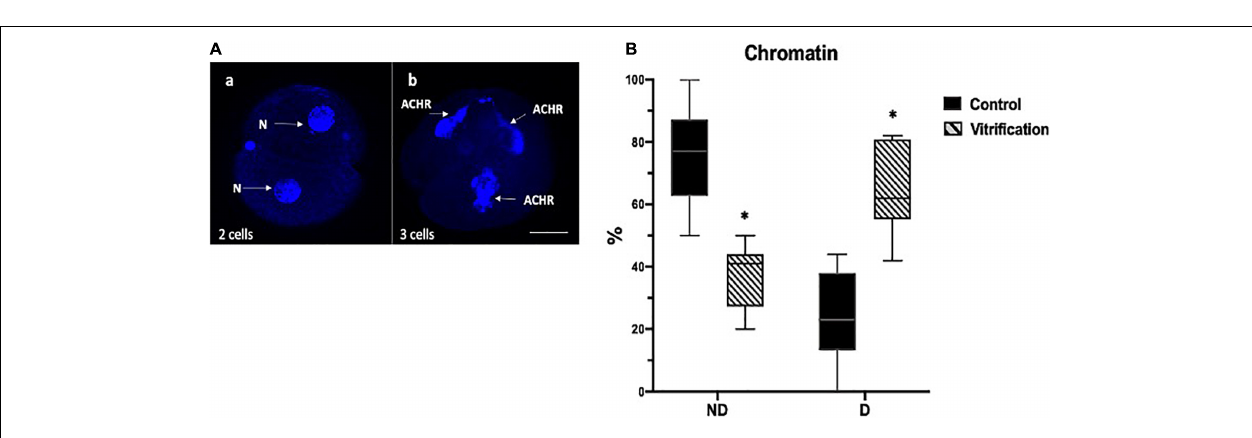
FIGURE 6 | Chromatin (CHR) evaluation in early ED by Hoechst staining in control and vitrified groups. (A) representative images for CHR evaluation criteria in early ED; (a) 2-Cell embryo, white arrows show nucleus without damage (ND), and (b) 3-Cell embryo, white arrows show abnormal chromatin (ACHR); the total numbers of evaluated cells in the control and vitrification groups were 64 and 33, respectively; 200 × , scale bar = 30 µ m; (B) percentage of CHR in early ED. ∗ Significant difference vs. control. P <